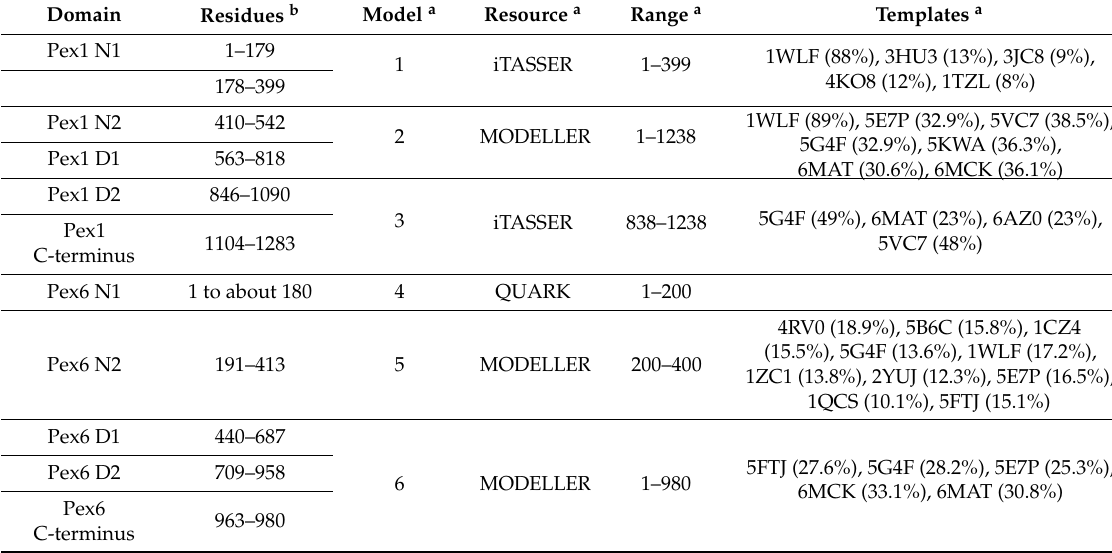
Table 2. Homology models of Pex1 and Pex6 generated and used in this study in conjunction with the individual domains of Pex1 and Pex6 they